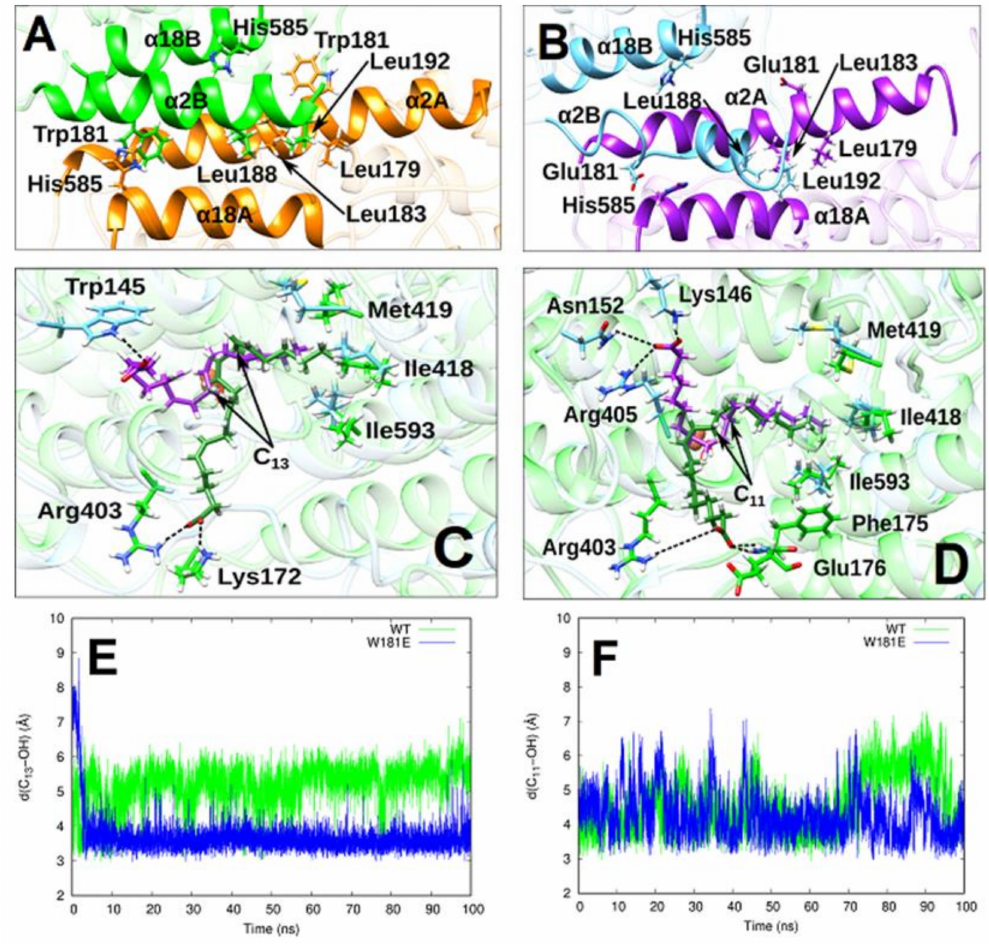
Figure 4. Structural consequences of Trp181Glu exchange on dimer formation and substrate alignment. ( A ) Inter-monomer interface of wild-type rabbit ALOX15. Secondary structural elements of conformer A are shown in mustard and those of conformer B are given in green. ( B ). Inter-monomer interface of the Trp181Glu mutant of rabbit ALOX15. Secondary structural elements of conformer A are shown in light blue and those of conformer B in purple. ( C ) Most representative binding mode of AA in WT-ALOX15 (dark green) and in Trp181Glu-ALOX15 (purple) dimers. WT-ALOX15 (green with a percentage of transparency) and Trp181Glu-ALOX15 (light blue with a percentage of transparency) backbones have been superimposed. The side-chains of some selected residues for WT-ALOX15 and Trp181Glu-ALOX15 dimers have been displayed in green and light blue, respectively. ( D ) Most representative binding mode of LA in WT-ALOX15 (dark green) and in Trp181Glu-ALOX15 (purple) dimers. WT-ALOX15 (green with a percentage of transparency) and Trp181Glu-ALOX15 (light blue with a percentage of transparency) backbones have been superimposed. The side-chains of some selected residues for WT-ALOX15 and Trp181Glu-ALOX15 dimers have been displayed in green and light blue, respectively. ( E ) C 13 -OH distance in the Trp181Glu-ALOX15-AA (in blue) and in the WT-ALOX15-AA (in green) complexes versus time. ( F ) C 11 -OH distance in the Trp181Glu-ALOX15-LA (in blue) and in the WT-ALOX15-LA (in green) complexes versus